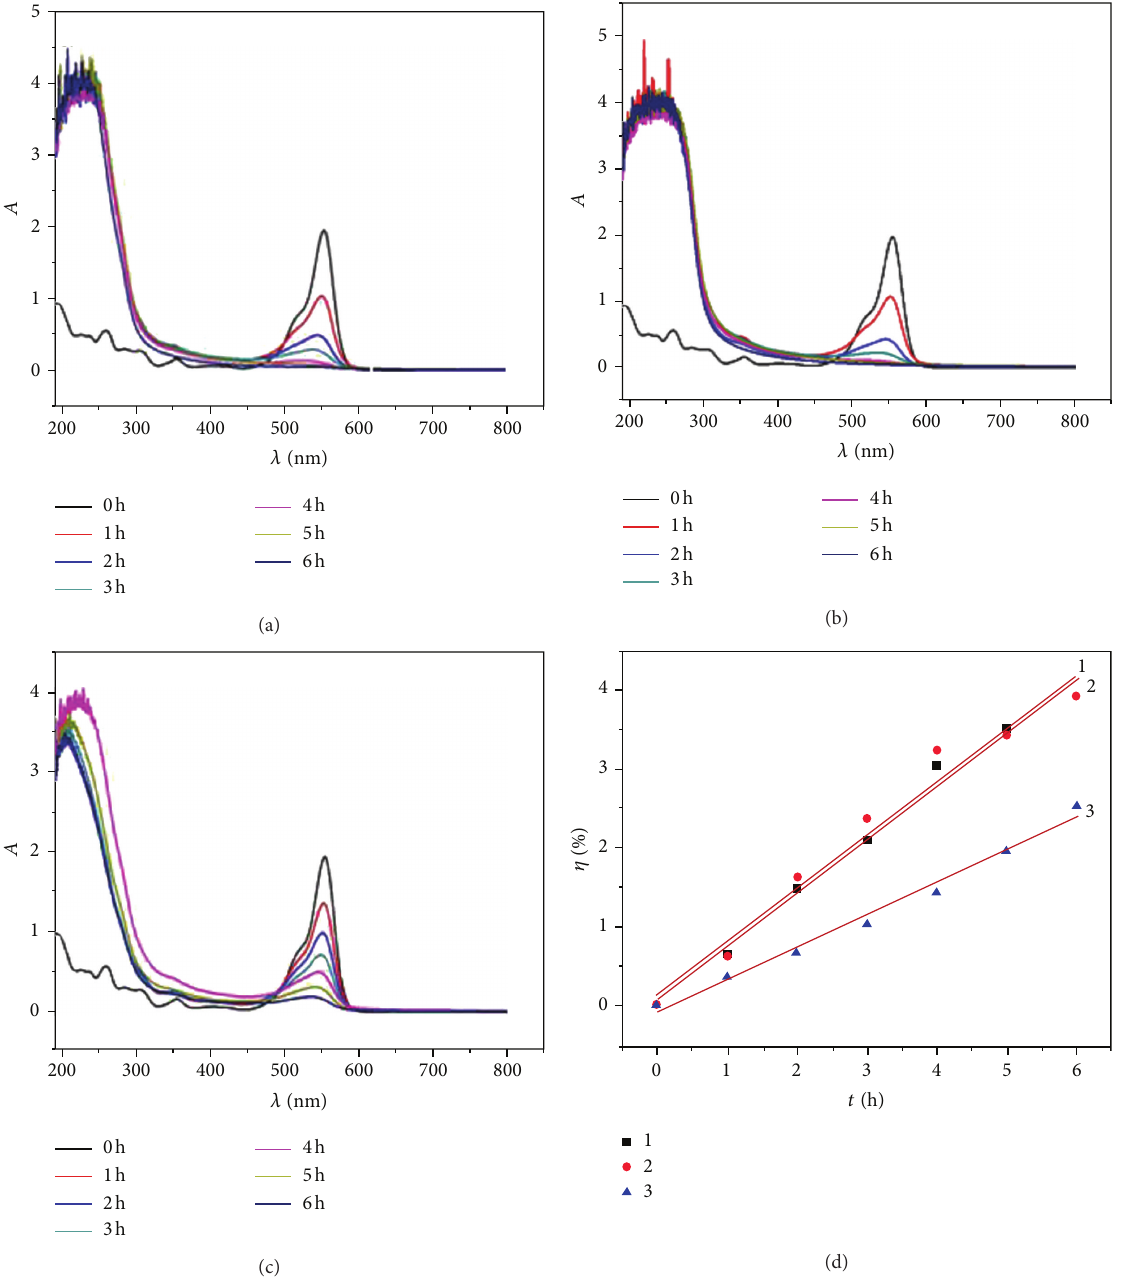
Figure 5: UV-visible absorption spectra changes of RhB with different as-prepared ZnWO 4 samples: (a) 140 ∘ C, 5min, (b) 160 ∘ C, 5min, and (c) 180 ∘ C, 5min. (d) Kinetics of degradation of RhB.